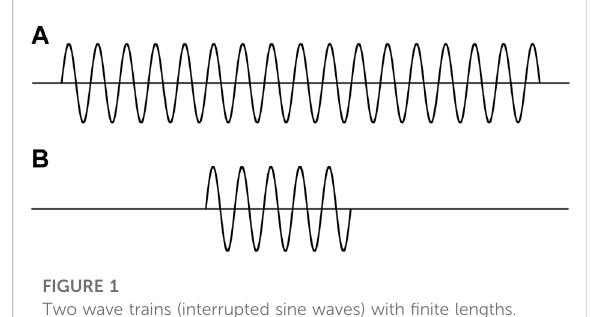
FIGURE 1 Two wave trains (interrupted sine waves) with fi nite